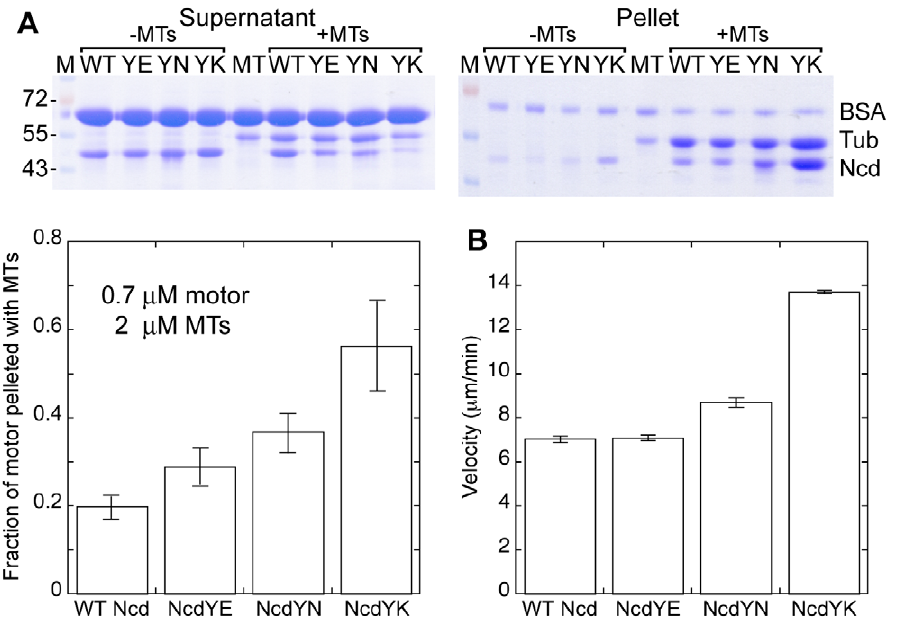
Figure 3. Microtubule binding and motility of NcdY485 mutants. (A) Microtubule binding. Top, supernatants (left) and pellets (right) from assays of motors with added ADP pelleted without or with microtubules. MTs, microtubules; M, M r markers (kDa); Tub, tubulin. Bottom, fraction of motor pelleted with added ADP and microtubules, after correction for motor that pelleted with added ADP but without microtubules. Assays performed in HEM100. (B) Microtubule gliding velocity. Assays in HEM with varying NaCl concentration to optimize motor-microtubule binding and gliding (WT, 50–280 mM NaCl; YE, 100–180 mM NaCl; YN, 250–300 mM NaCl; YK, 250–400 mM NaCl). Error bars, mean 6 SEM.